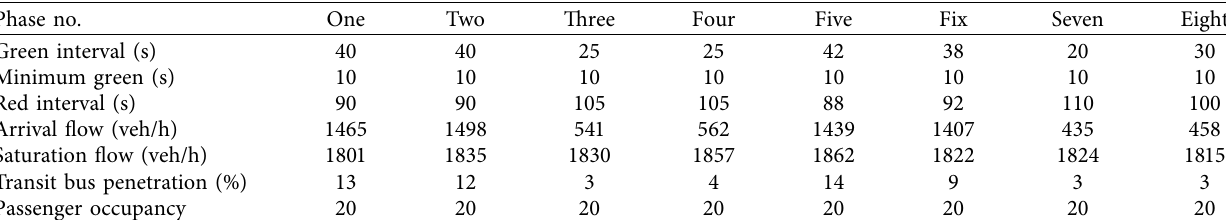
Figure 4: Field test environment. (a) Trafc movement and device layout. (b) Signal phase and timing graph. Table 2: Fixed timing and trafc